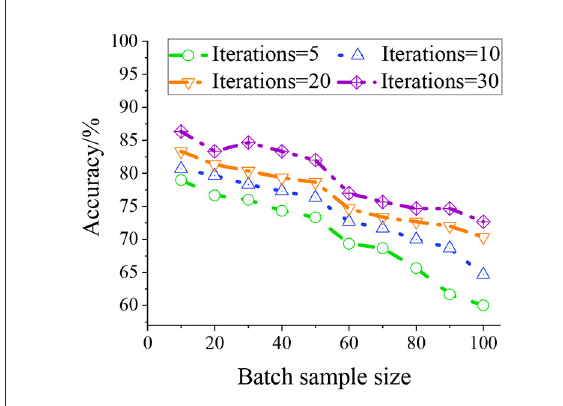
FIGURE6 Influence of the number of samples in different batches on the recognition effect.